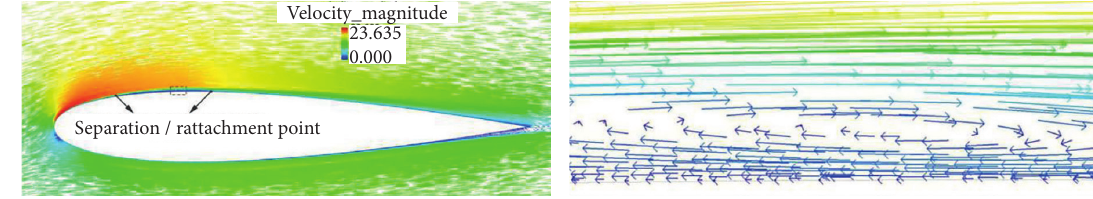
Figure 7. Profile of the velocity field in Rec = 2.38 × 10 5 and AoA = 6 with extended detail.